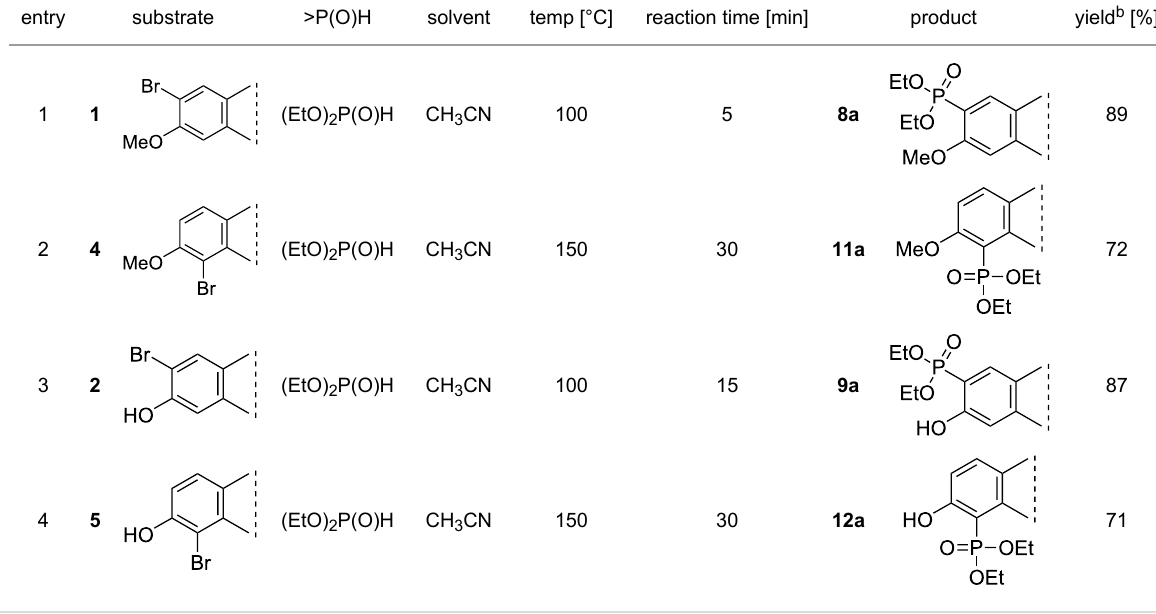
Table 2: Scope of the reaction a of 2- or 4-bromo-13 α -estrones 1 – 6 with diethyl phosphite ( 7a ) or diphenylphosphine oxide ( 7b ).